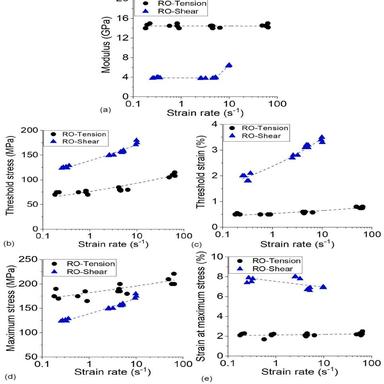
Comparison of a) modulus, b) ultimate strain, c) ultimate stress, d) threshold stress, e) threshold strain after performing tensile and shear tests at different strain rates for RO-A-SMC composite.